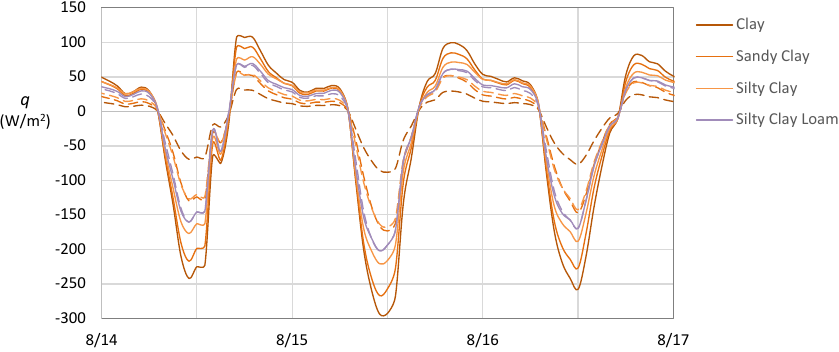
Figure 5. Effect of soil moisture on sensible heat flux, shown by comparison of fluxes predicted using moisture-dependent thermal conductivity values (solid lines) with those predicted using dry thermal conductivity values (dashed lines), illustrating a difference of up to ten-fold during daytime sensible gain as well as nighttime heat loss. Data show hourly values at the outer surfaces of Mexican green roof soils, each 10 cm in thickness, in the semi-arid steppe climate of Laredo, TX, USA (Köppen BSh , Table 3; Figure 8); ambient humidity was the only source of moisture.